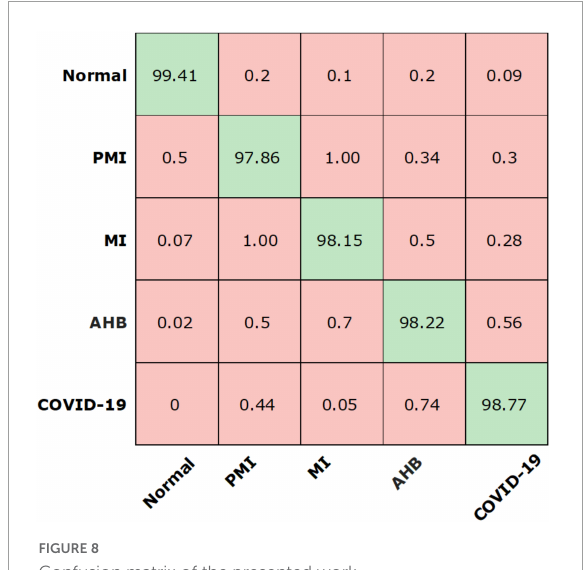
FIGURE8 Confusion matrix of the presented work.